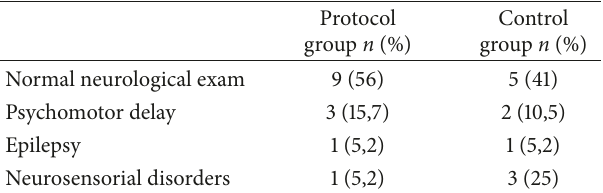
Table 5: Data from the neurological assessment at the age of 18